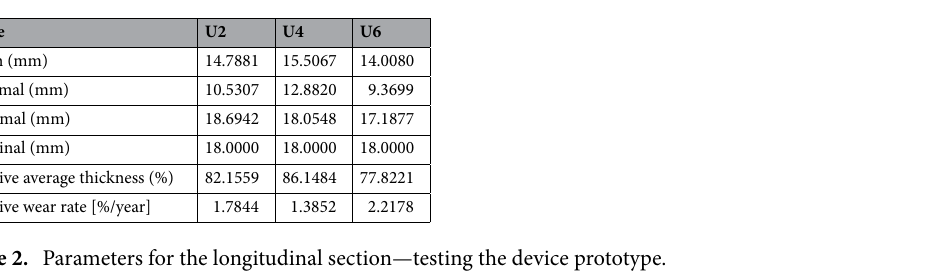
Figure 6. Overall longitudinal section through a conveyor belt—device prototype testing.